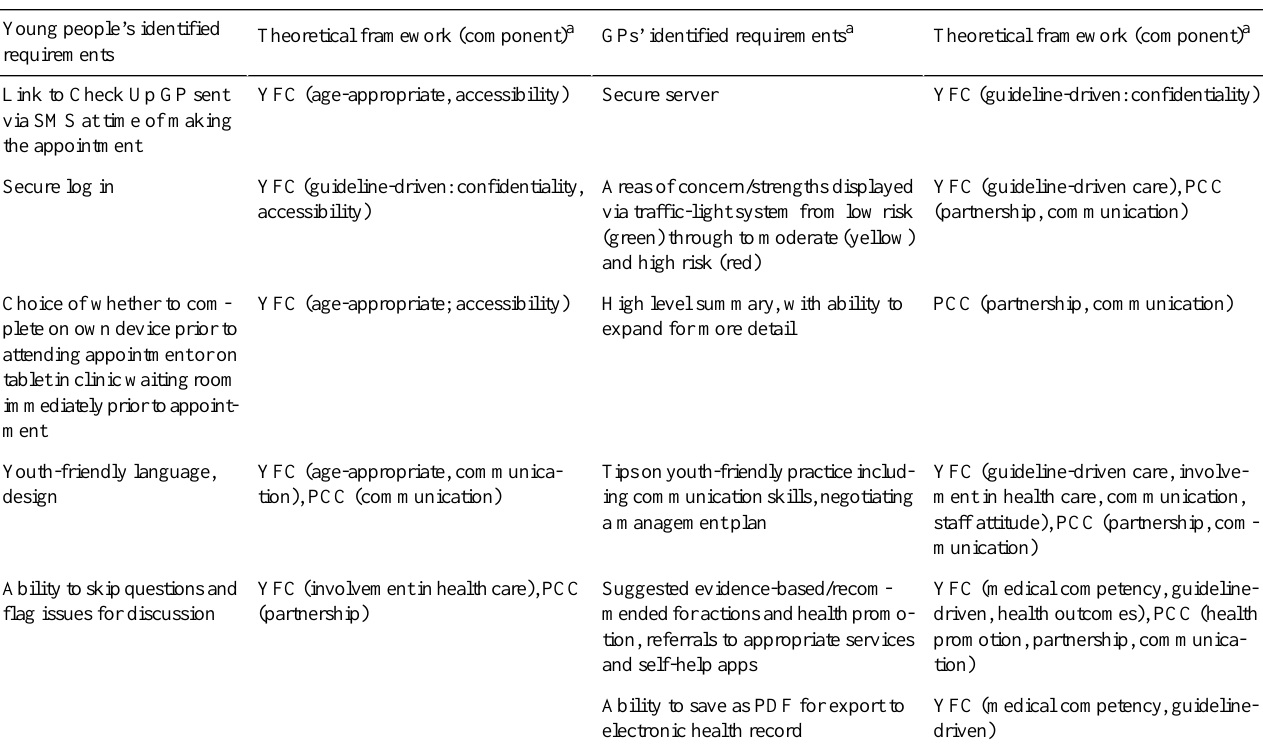
Table 1. Key technology and design features of Check Up GP according to codesign workshop requirements and theoretical framework components.